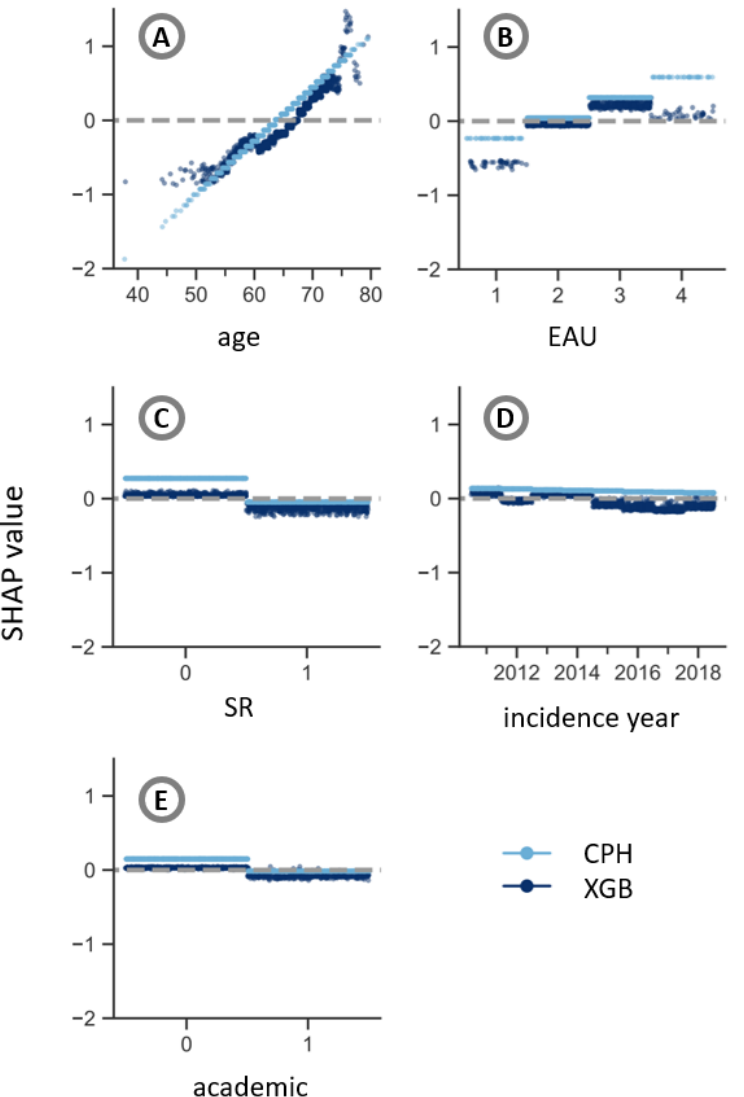
Figure 4. Dependence plot for all features: ( A ) age ; ( B ) EAU (encoded as 1—low risk/localised, 2— intermediate risk/localised, 3—high risk/localised, and 4—high risk/locally advanced); ( C ) SR (en- coded as 0—False, 1—True); ( D ) incidence year ; ( E ) academic hospital (encoded as 0—False, 1—True). Each dot corresponds to one patient. In the case of categorical features (i.e., all features except age ), artificial jitter was added along the x -axis for the sake of easier representation. The y -axis scale is the same for all features in order to give a proper idea of their contributions to the model